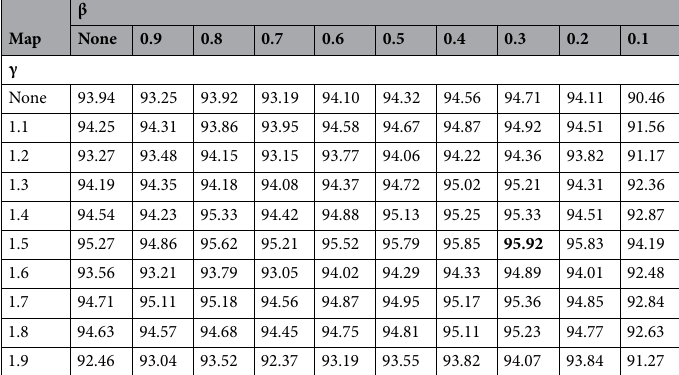
Table 2. The effect of γ and β on accuracy. Maximum values are in bold.